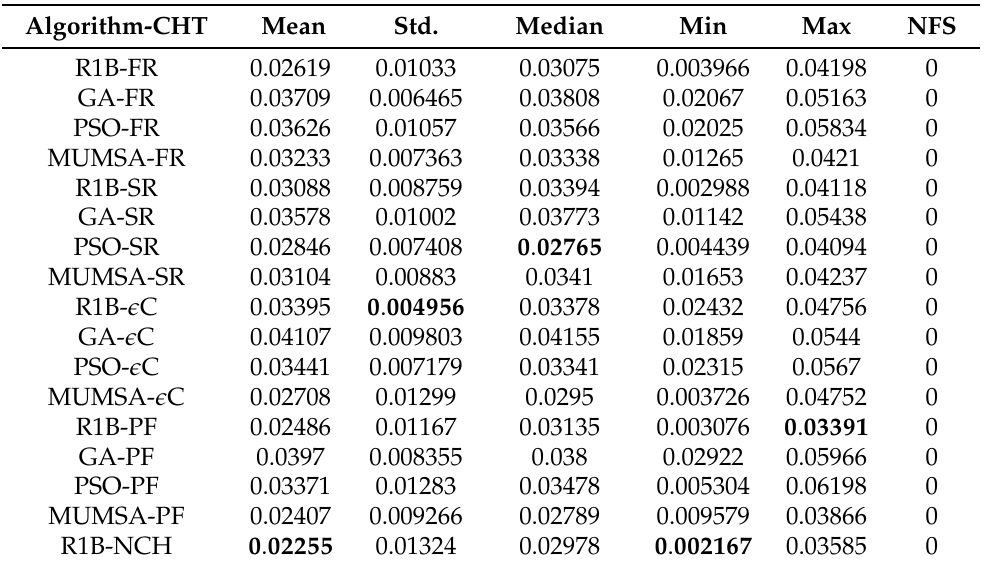
Table 5. Descriptive statistics of the obtained results for each metaheuristic algorithm in study case 1 with trajectory 1.